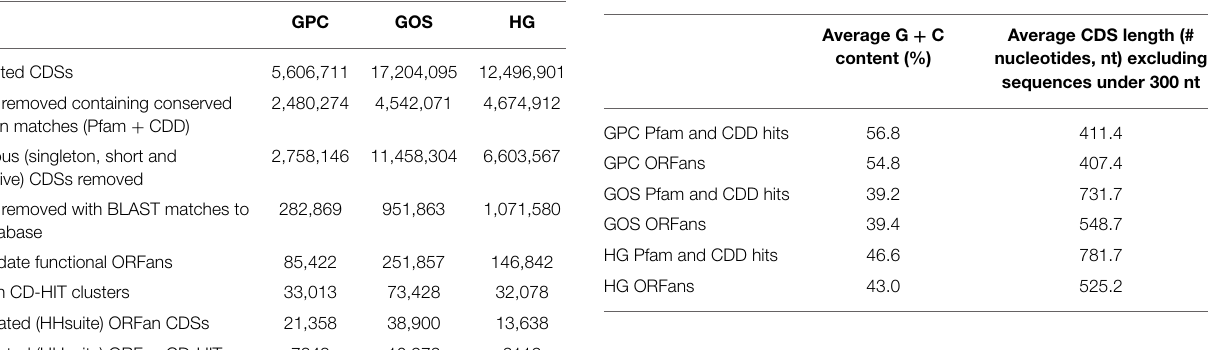
TABLE 1 | Number of CDSs and ORFans at key stages of metagenomic ORFan identification.